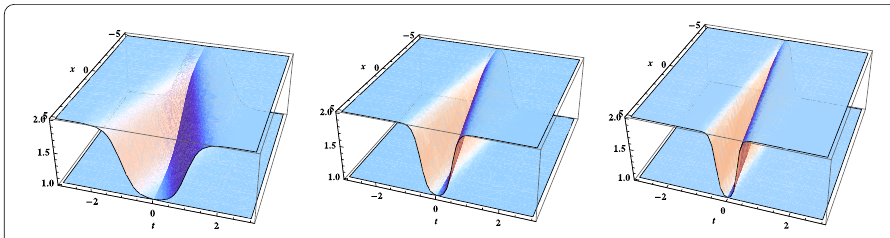
Figure 4 Shapes of the two-waves depicted in (2.12) by increasing the phase velocity: s = 5,10,15, respectively, and the other assigned values are d = μ = A 0 = A 1 =